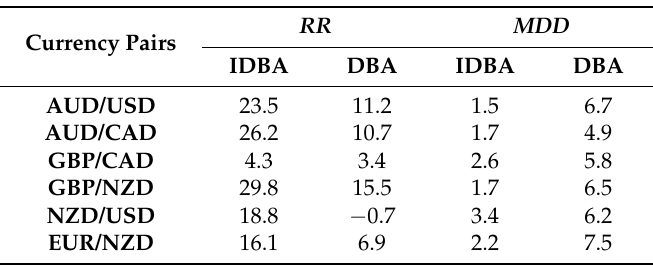
Table 10. Summary of RR and MDD of IDBA and DBA.